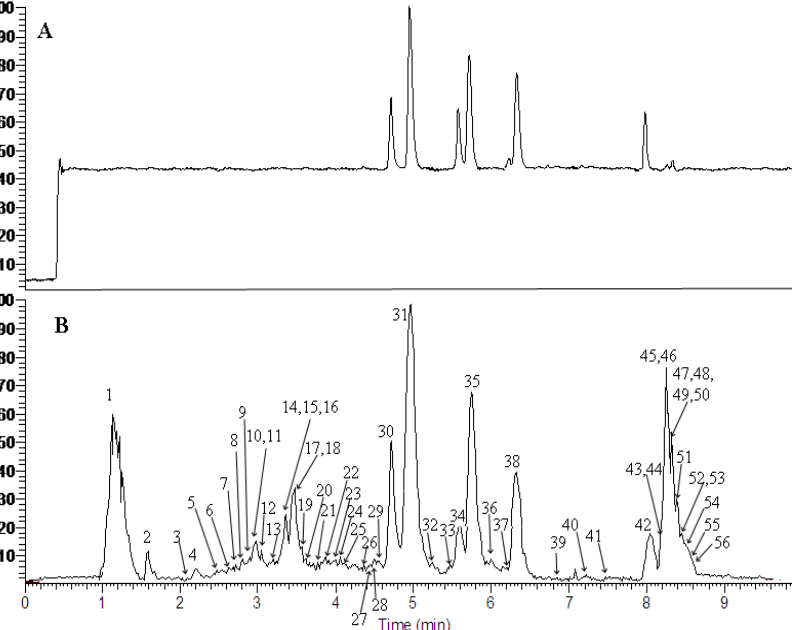
Figure 1. UHPLC-(-) ESI-MS total ion chromatograms of a mixture of six standards ( A ) and the extract of Smilacis glabrae ( B